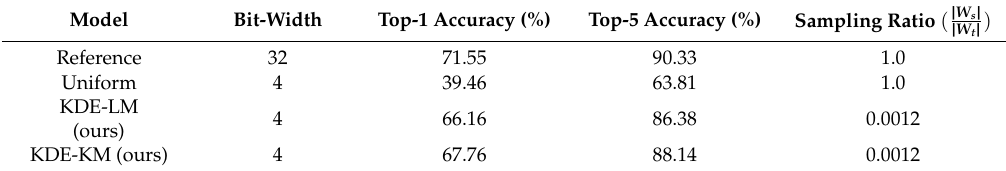
Table 2. Performance comparison of VGGNet-16 architecture.